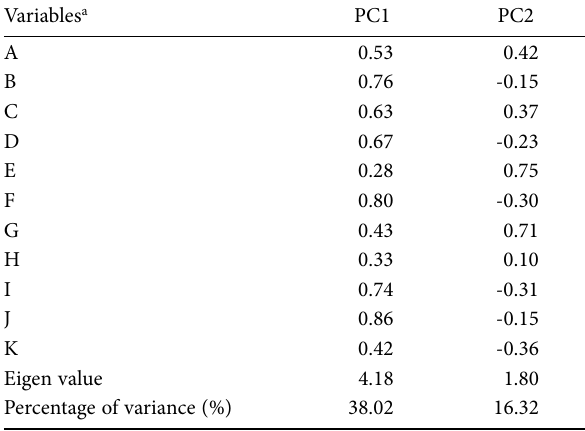
Table 7. Eigen vectors of the two principal components axes (PC1 and 2) for the 11 variables assessed (resistance heterogeneity in the landraces expressed as the percentage of resistant plants in suscep- tible landraces and the percentage of susceptible plants in resistant landraces, for each of the 11 Puccinia striiformis f. sp. tritici patho- types), and their contributions to the variance.